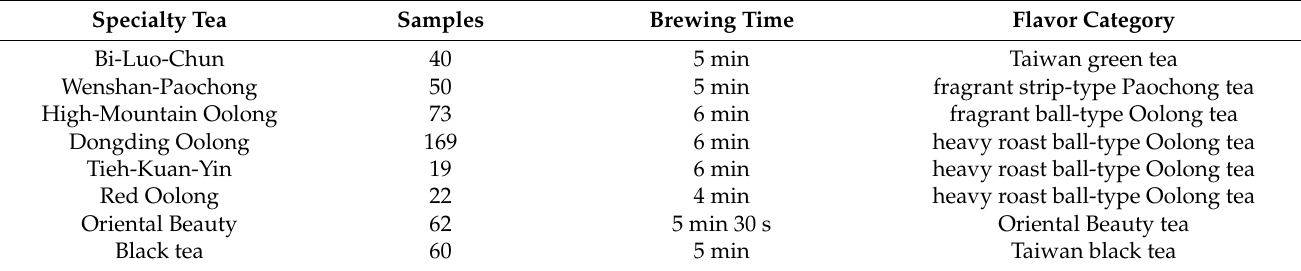
Table 1. The brewing time and flavor categories applied for the eight specialty